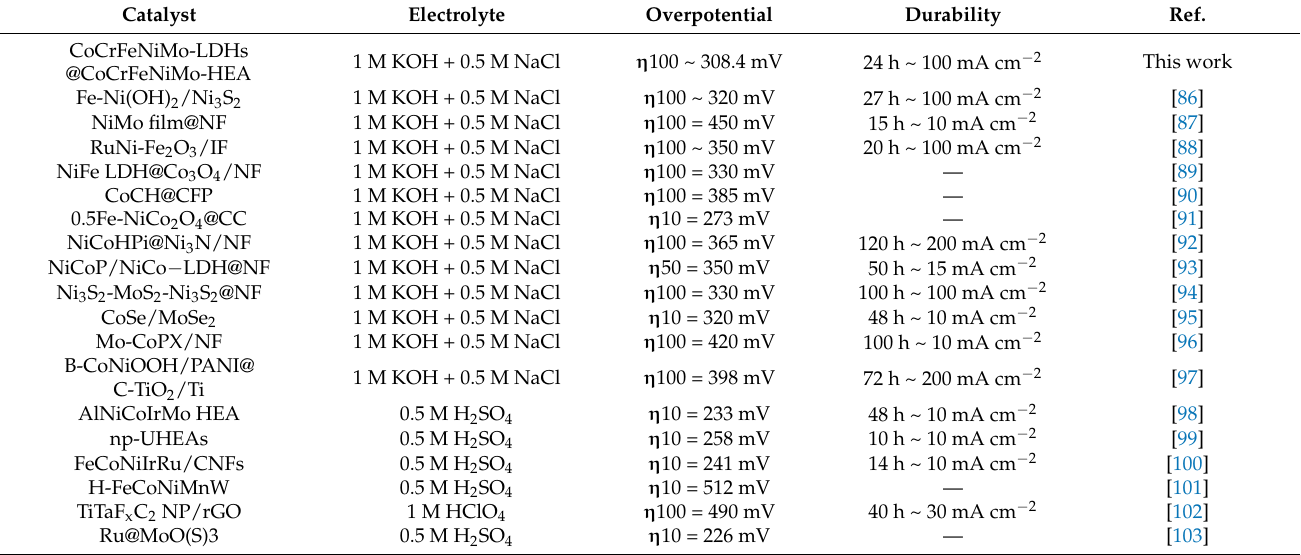
Table 1. Activity for OER of catalyst in this work in comparison with other catalysts with multi-elements. Catalyst Electrolyte Overpotential Durability